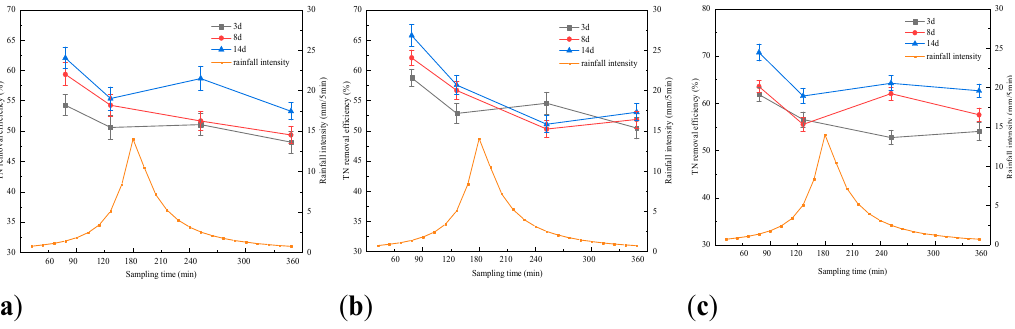
Figure 9. The efficiency of TN removal using bioretention systems with the ( a ) Control column, ( b ) DS column, and ( c ) SZ column during different antecedent dry periods.